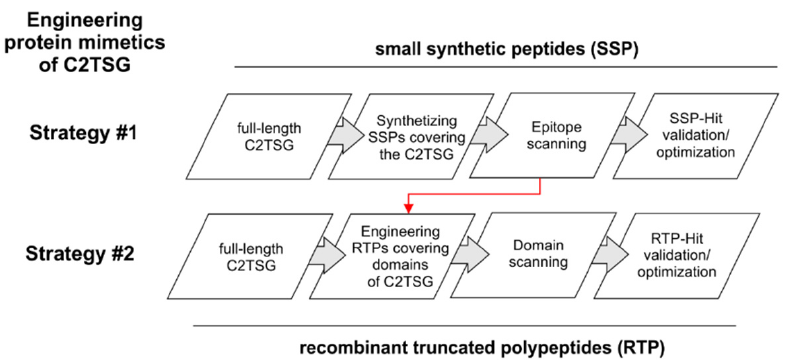
Figure 3. Schematic workflow to present two different strategies to engineer protein mimetics of C2TSG proteins, simulating/restoring their tumor suppressive function. Strategy #1 involves a systematic epitope scanning using partially overlapping chemically synthesized peptides covering the whole C2TSG protein to highlight hit regions. Strategy #2 follows the biological protein structure considering distinct protein domains. On this basis, truncated polypeptides are engineered and synthesized in vitro. Red arrow: data of hit regions of the epitope mapping study could be considered for prioritization of domains in Strategy #2.